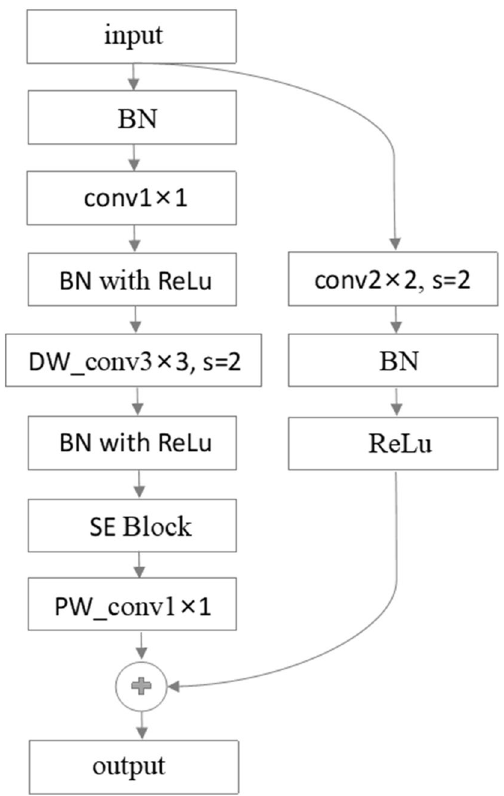
Figure 8. Convolutional building